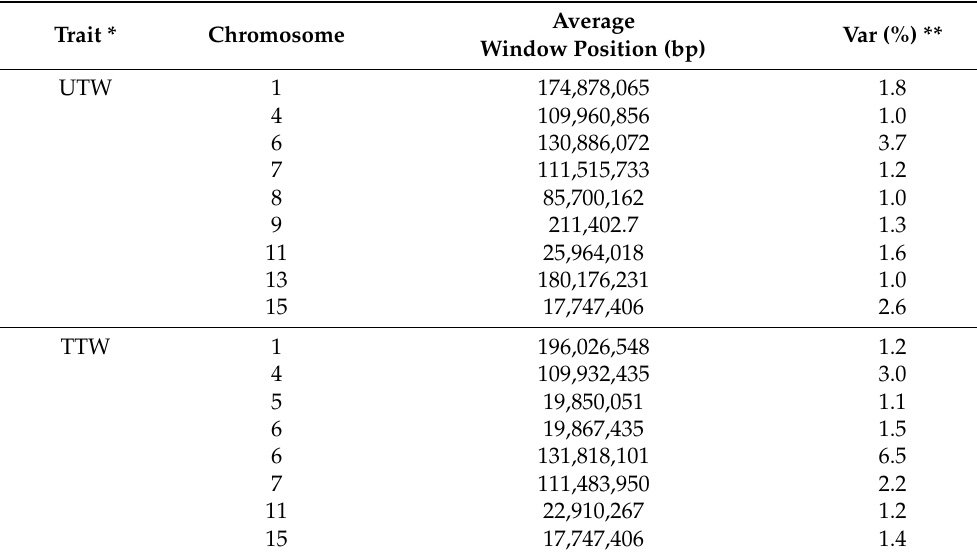
Table 3. The top SNP windows that explained the highest proportion of genetic variance of each trait for each chromosome.